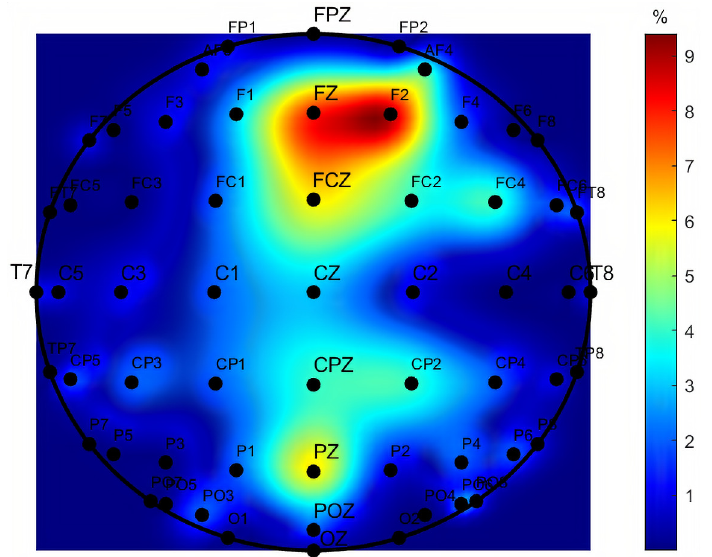
Figure 8. Topographic map representing the percentage of the features corresponding to each electrode after feature selection with Kruskal–Wallis H test, for the multiclass scenario C1 vs. C2 vs. C3 vs.